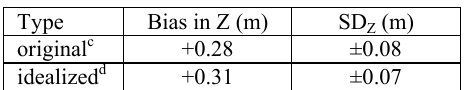
Table 5. Bundle adjustment with Pix4Dmapper (2015 image data, 4 photographs).